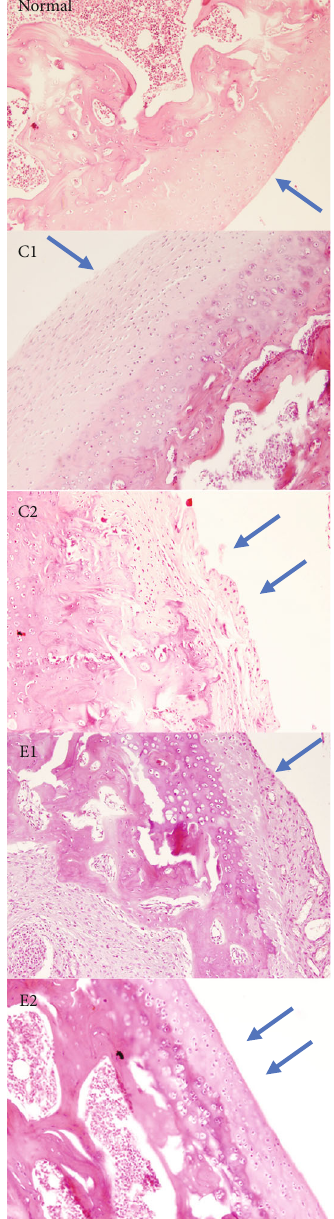
Figure 2: A typical histological section from all groups ’ surface of articular cartilage (H&E, × 200). E2 group: synovial membrane- based stem cells, arranged chondrocyte in columnar cluster along with continuous and smooth surface of articular hyaline cartilage with no foci of abnormal calci fi cation; E1 group: adipose tissue- derived stem cells, the surface of articular cartilage was mainly continues composed of fi brocartilage tissue arranged in clusters, and the subchondral bone was detached with increased remodeling; C2 group: treated with Hyalgan, the surface of articular cartilage was continuous mainly composed of fi brocartilage with foci of hyaline cartilage cluster; and C1 nontreated group, the surface of articular cartilage was completely destructive and composed of disorganized fi brocartilage and fi brous tissues, and the subchondral bone was